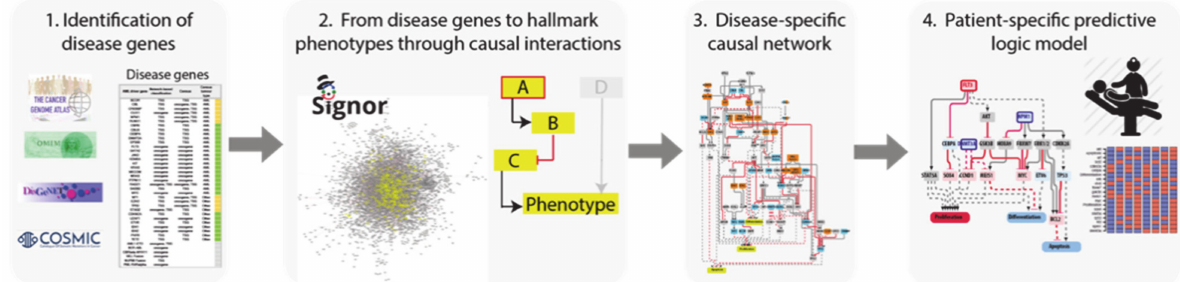
Figure 1. Schematic representation of the network-based